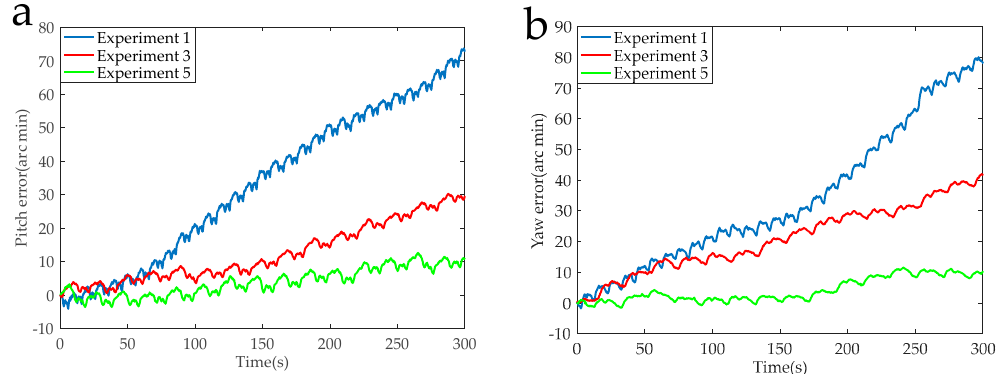
Figure 13. ( a ) Pitch error curves of the Experiments 1, 3, and 5. ( b ) Yaw error curves of the Experiments 1, 3, and 5.